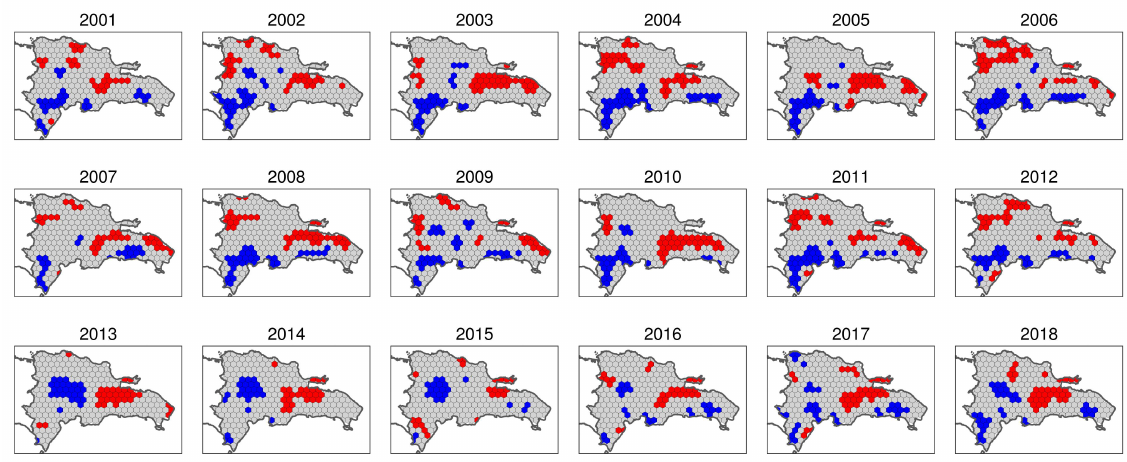
Figure 10 – Yearly LISA maps (local indicators of spatial association maps) of transformed forest loss density data of small clearings. See Figure 9 for colour legend of